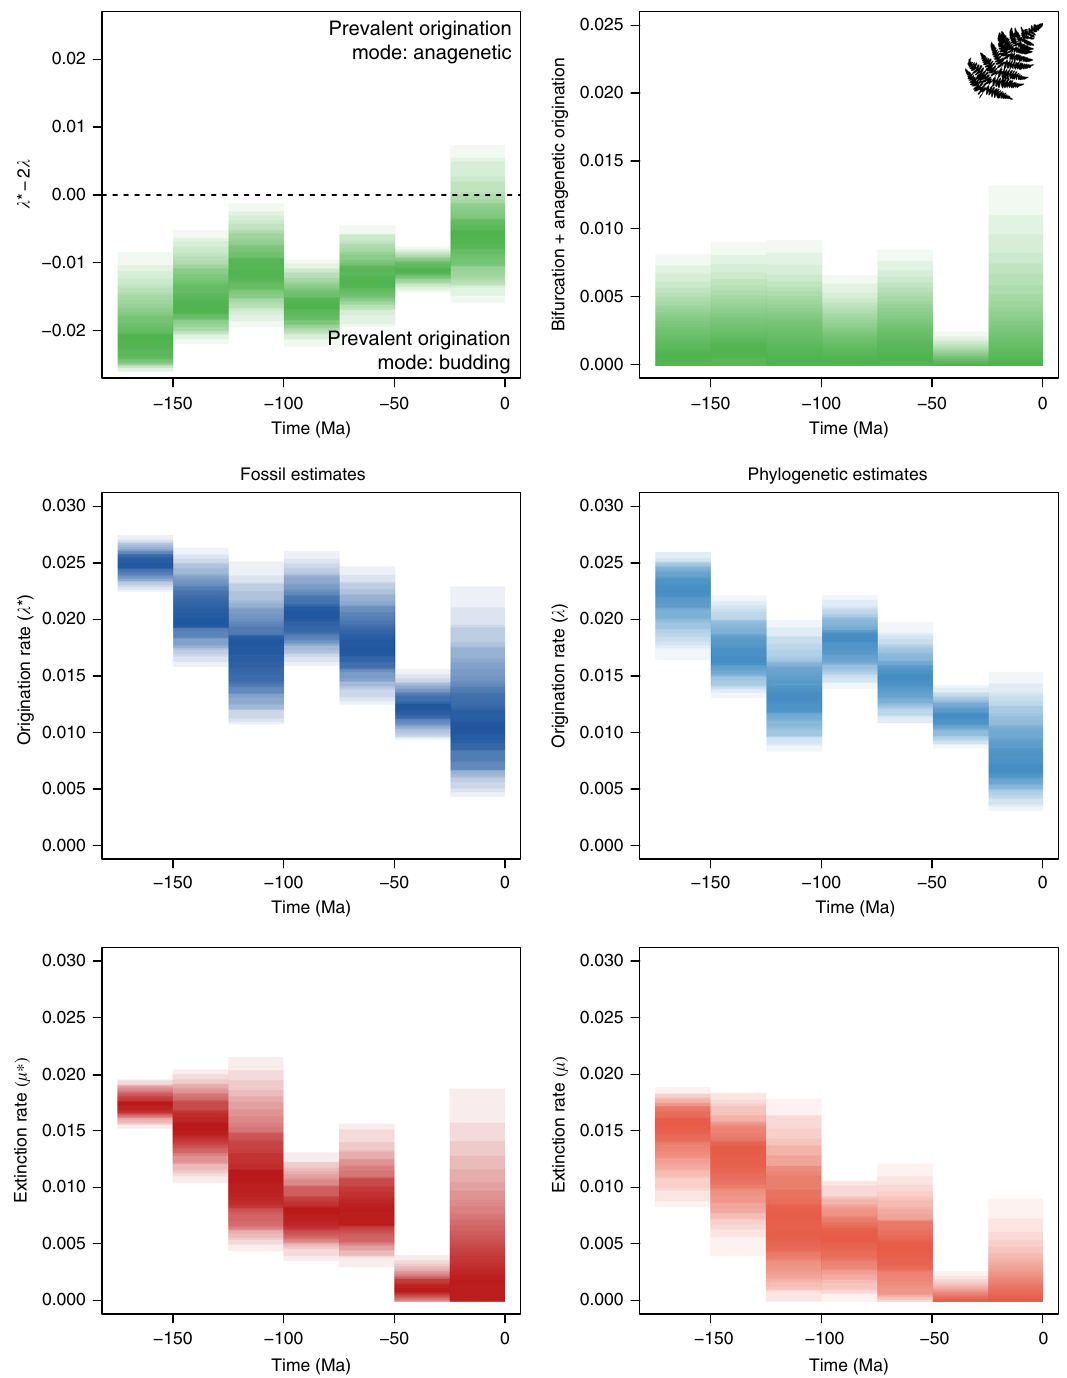
Fig. 5 Analysis of the fern data set under the BDC skyline model. Origination and extinction rates were jointly inferred within each time bin from the fossil record and phylogenetic tree, under the constraints imposed by the BDC model. Prevalent modes of origination (in green) indicate that, as expected for a genus level data set, budding was more important than anagenetic origination, and that there is a low but non-zero rate of bifurcation and anagenesis. Origination and extinction rates inferred from fossils and from the phylogeny of ferns show a substantial amount of variation through time with a general tendency to decrease over time, although the net diversi fi cation remains positive in most of the time